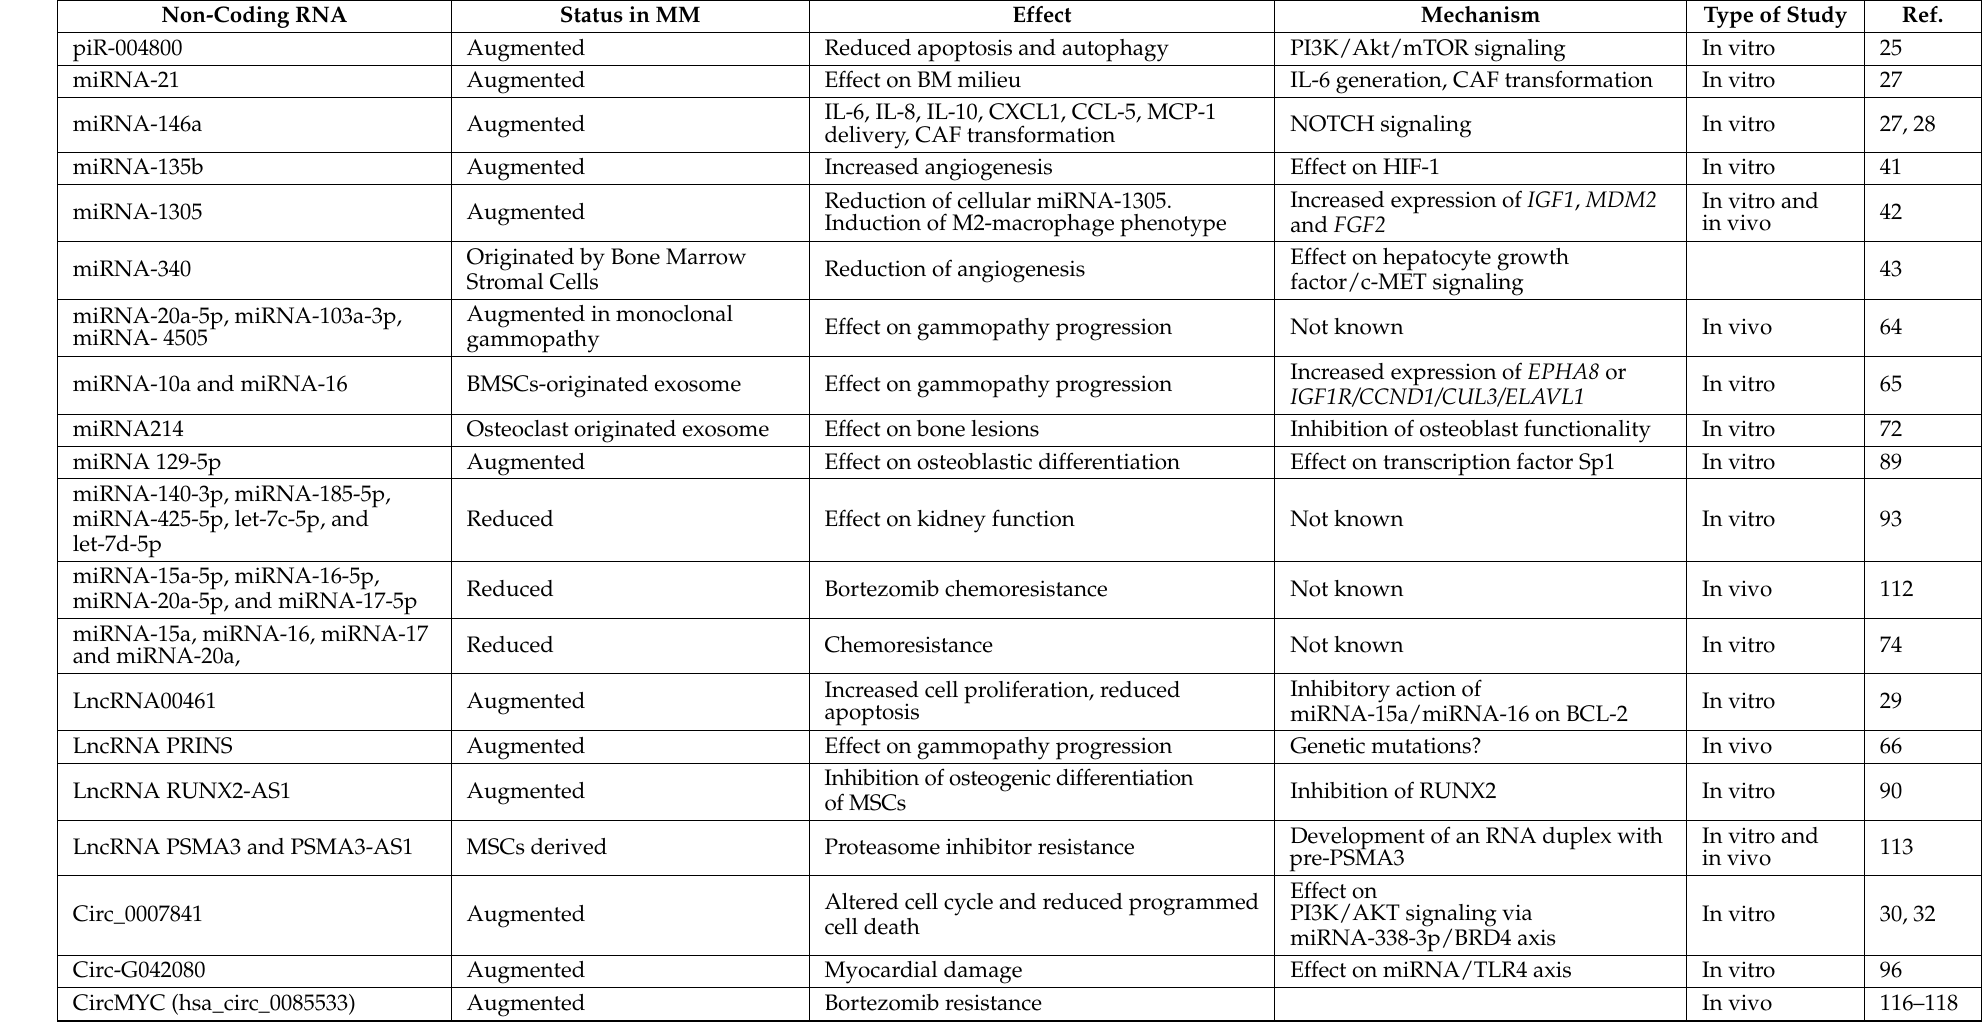
Table 1. Main effects of non-coding genetic materials on multiple